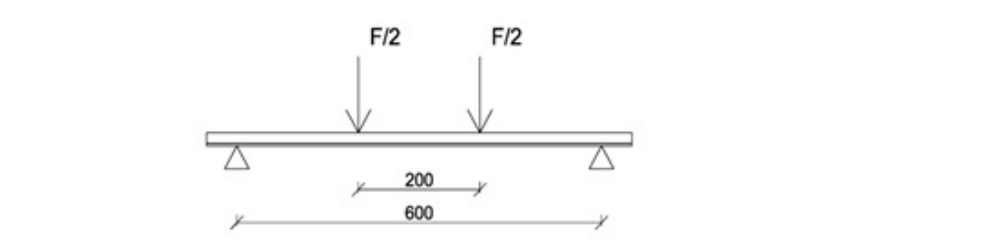
Figure 5. The static scheme of slab loading.